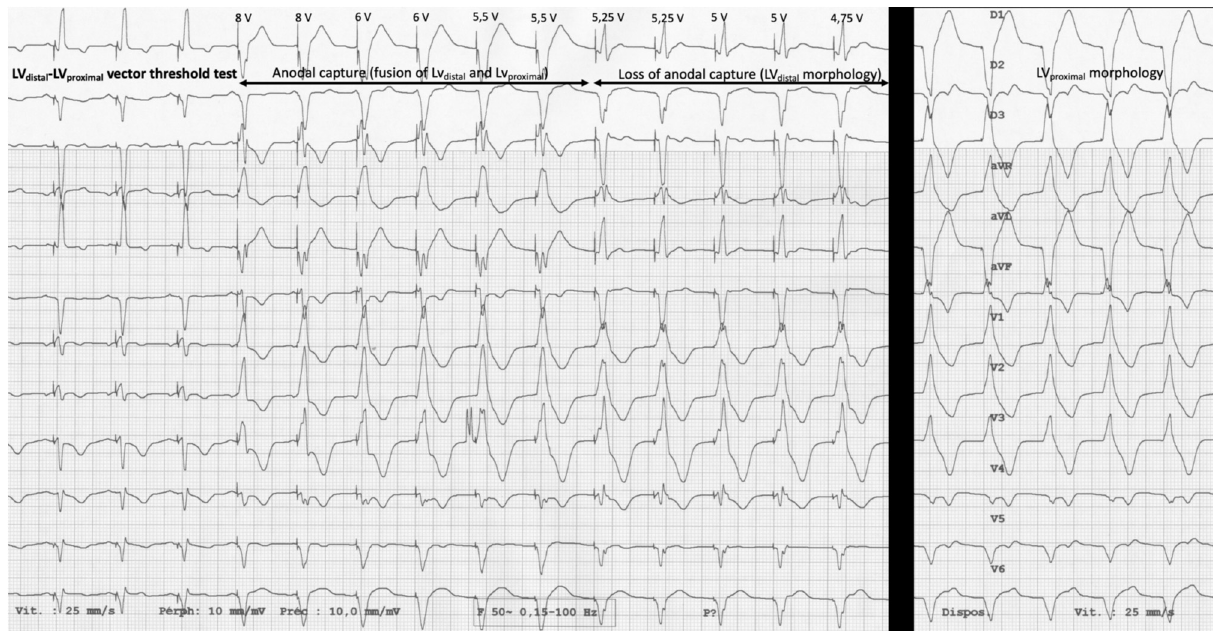
Figure 2. “Pseudo MPP” threshold measurement. Example with LV distal − LV proximal vector threshold test with an impulsion duration of 0.4 ms. An abrupt change in QRS morphology can be identified between 5.5 V and 5.25 V, 5.5 V being considered as the “pseudo-MPP” threshold. “Pseudo-MPP” QRS morphology results from the fusion of mono-LVp distal and mono-LVp proximal QRS morphologies.